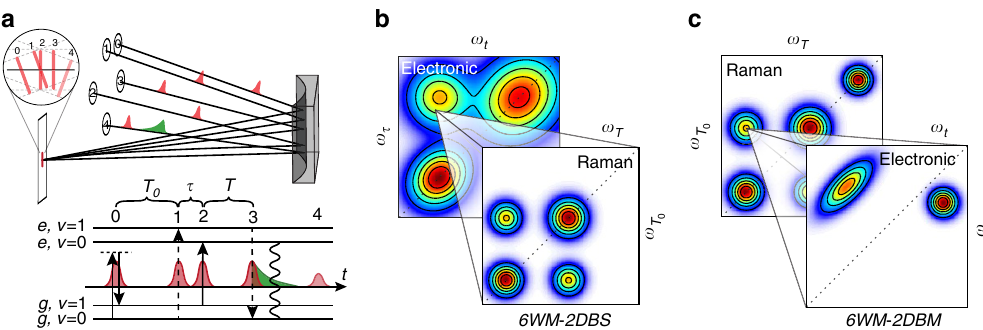
Figure 1 | Overview of the GAMERS technique. ( a ) In a simplified schematic of gradient-assisted multidimensional electronic Raman spectroscopy (GAMERS), 5 pulses are focused to a line in the sample and the radiated signal field is spectrally dispersed onto a 2D CMOS sensor (camera), where it is detected as a function of wavelength (horizontal dimension) and the delay t (vertical dimension). An inset shows the pulse tilts at the focus. Below, an energy ladder diagram depicts an example six-wave mixing (6WM) signal generation pathway in a four-level system composed of two electronic states ( g and e ), each with two vibrational levels ( v ¼ 0 and v ¼ 1). ( b ) Slices of a model 4D 6WM spectrum illustrate that it effectively contains a 2D Raman spectrum (6WM 2D beating slice spectrum) at each point in the 2D electronic spectrum. ( c ) A beating map (6WM 2D beating map spectrum) constructed from a specific 2D Raman frequency highlights parts of the 2D electronic spectrum associated with the chosen